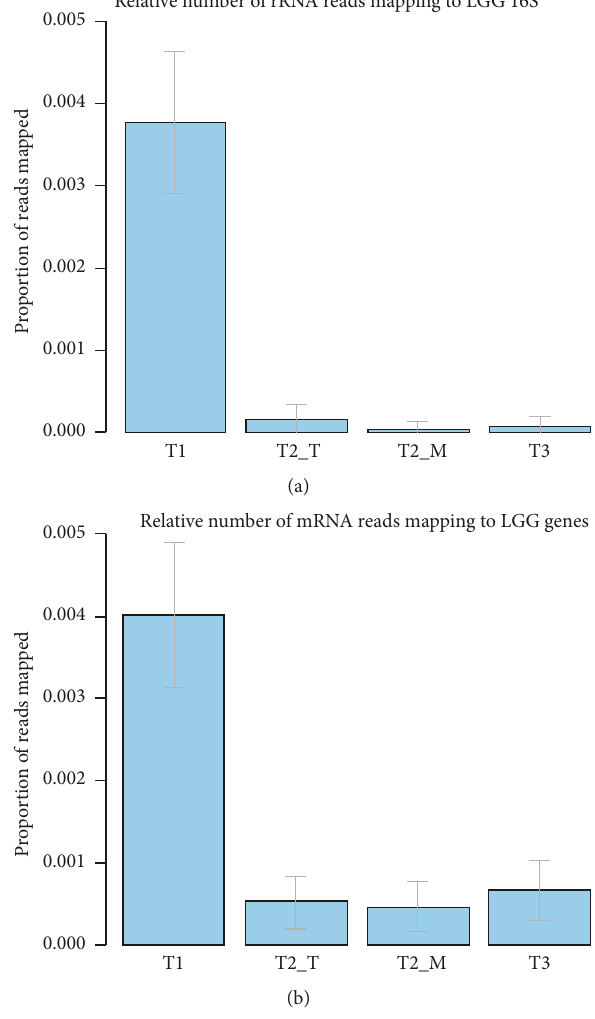
Figure 6: Relative numbers of mRNA (b) and rRNA (a) read mapping to LGG. Error bars represent standard deviations based on binomial